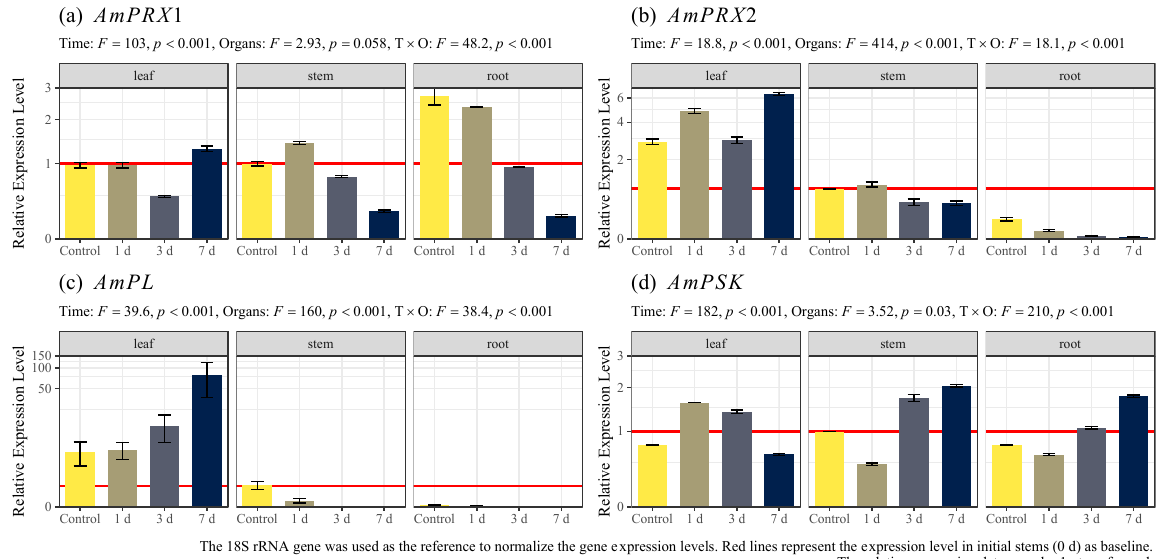
Figure 4. Temporal expression patterns of AmPRX1 , AmPRX2 , AmPL , and AmPSK genes in different tissues of A. marina under cadmium stress.